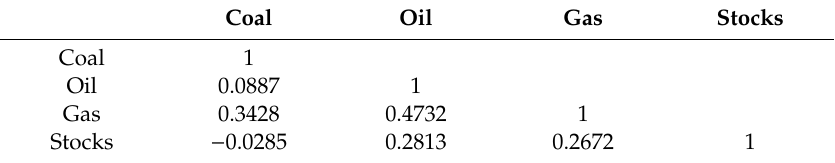
Table 9. Correlations for Austria.